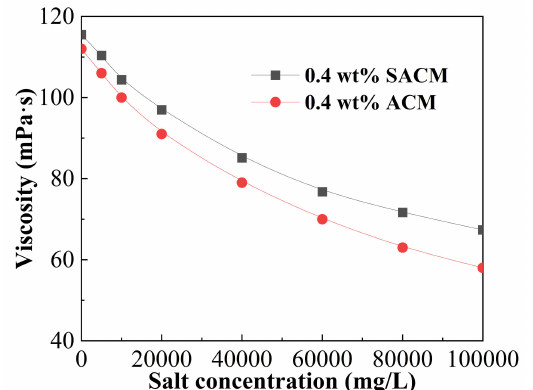
Figure 5. Effect of salinity on viscosity of suspension diluent and powder